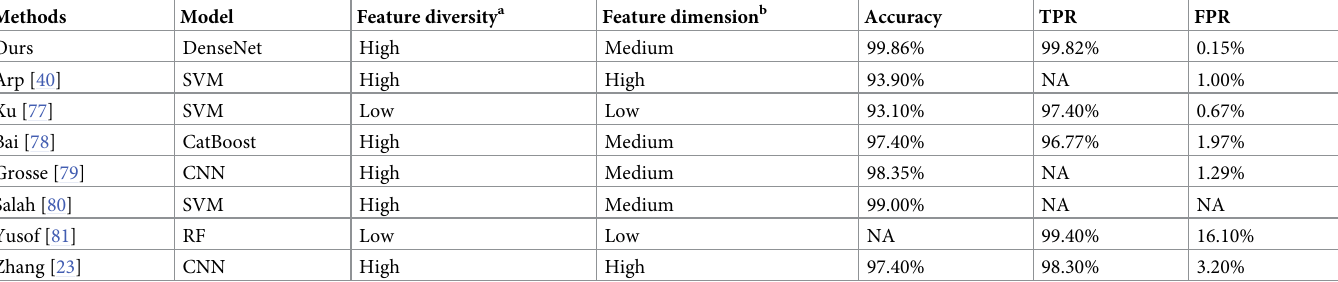
Table 17. The performance of each neural